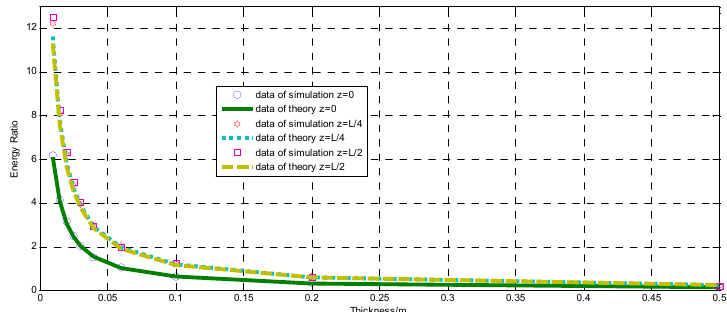
Figure 25. The energy time history with thickness t = 0.01 m, x = 0.0 m and z = 0, z = L / 2 respectively. ( a ) z = 0.0 m. ( b ) z = L / 2 m.